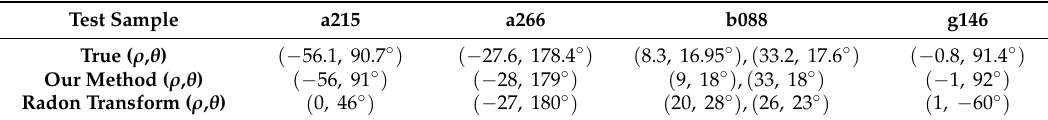
Table 1. The orientation of true and detected straight